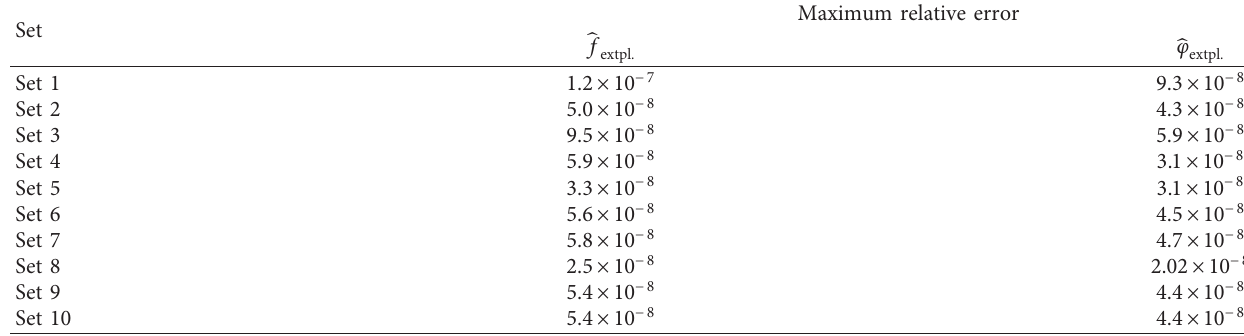
and 􏽢 φ with Δ τ � 0 . 01and Δ v � 0 . 01. extpl . extpl .